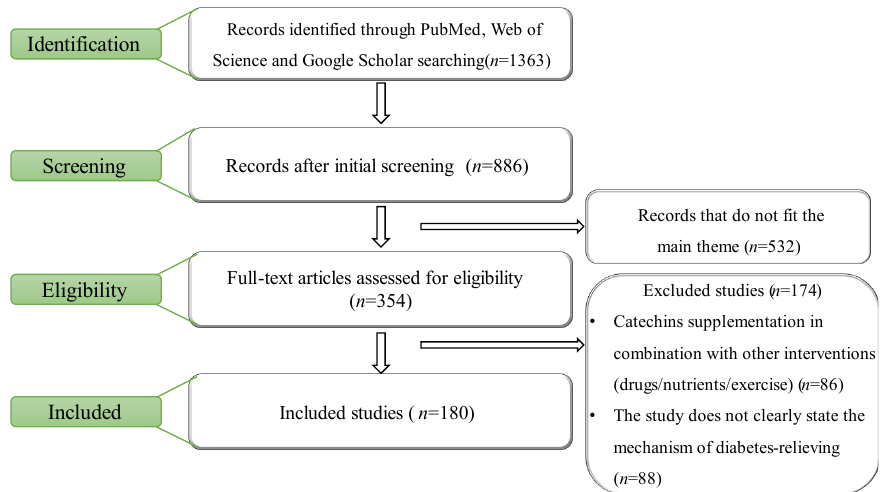
Figure 1. Study selection flow adapted from a systematic review by Muhammad Subhan Alfaqih et al. [9].